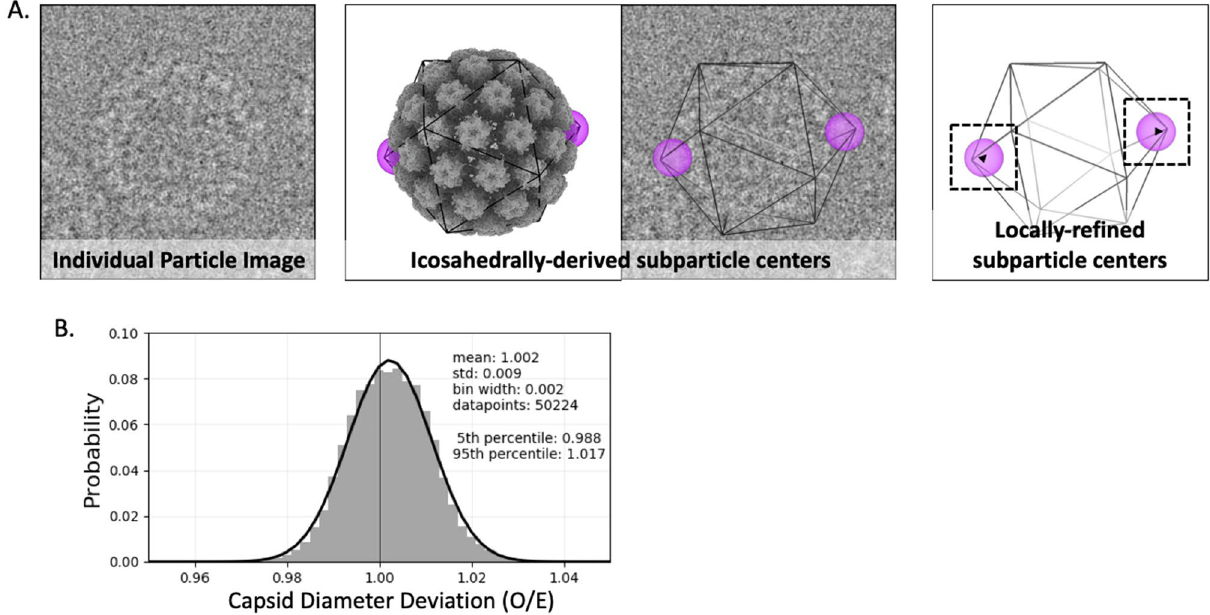
Figure 5. Capsid diameters. ( A , left) From a cryo EM micrograph, an example of a particle oriented with opposing pentavalent capsomers in the Z = 0 plane (within a tolerance, see “Methods” section). ( A , center) The same particle also illustrated in a 3D surface rendered model (gray) and outlined with icosahedral cage (black line) with opposing pentavalent capsomers indicated (purple spheres). The particle origin and orientation found during icosahedral refinement, determines the idealized capsomer locations. ( A , right) Local subparticle refinement identifies the actual capsomer centers, which allows calculation of the deviation (black arrowheads) of the diameter along the given axis from expected values. ( B ) A gaussian distribution of capsid diameters (black curve) is evident after pooling all qualifying particles. A standard deviation of 0.9% corresponds to ~ 4.6 Å, or 4.2 pixels at a pixel size of 1.1